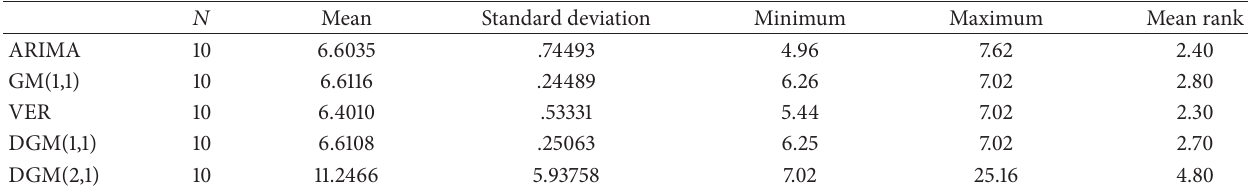
Table 5: Descriptive statistics of forecasting results in the CPI section.